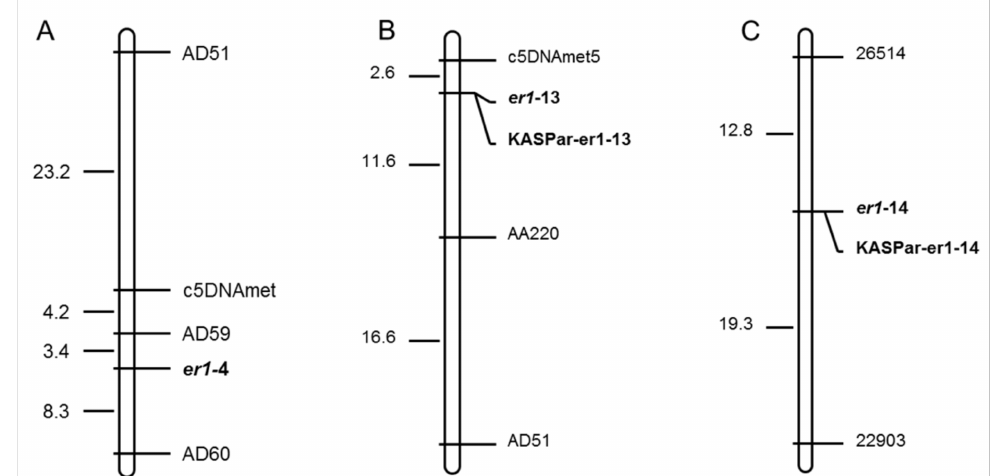
Figure 2. Genetic linkage maps constructed using the er1 -linked markers and the functional markers for er1 -13 and er1 -14, based on the F 2 populations derived from ( A ) Bawan 6 × Suoshadabaiwan, ( B ) Longwan 1 × Dabaiwandou, and ( C ) Chengwan 8 × Guiwan 1. Map distances and loci order were determined with MAPMAKER v3.0. Estimated genetic distances between loci are shown to the left of the maps in centiMorgans